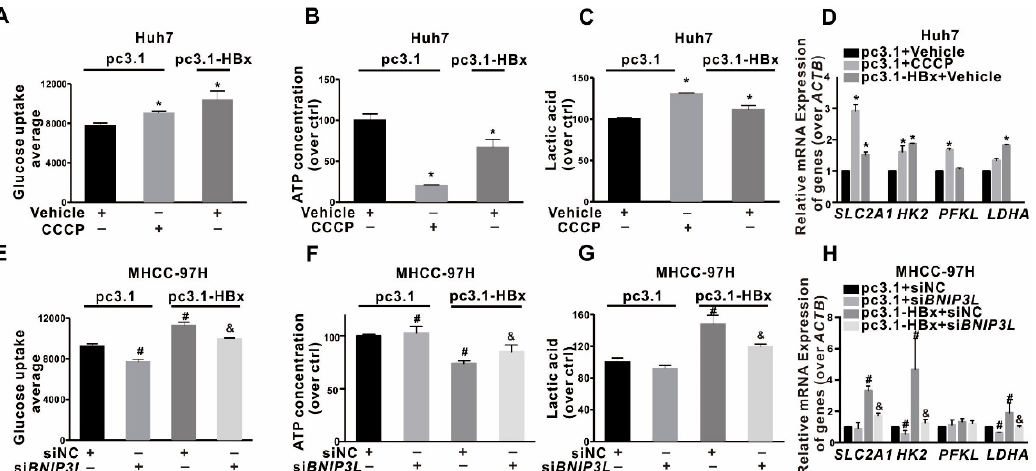
Figure 7. Relationship between the BNIP3L-dependent mitophagy and glycolysis metabolism reprogramming in HBx-expressing HCC cells. ( A – D ) Huh7 cells without or with HBx-expressing were transiently transfected with pcDNA3.1 or pcDNA3.1-HBx (1 μ g/mL) for 8 h, and pretreated with CCCP (20 μ M) for 3 h or not. ( A ) Glucose transport activity was evaluated by FCM. The levels of the intracellular ATP content ( B ), the extracellular lactic acid secretion ( C ), and the mRNA levels of glycolysis-related genes ( D ) were detected. ( E – H ) MHCC-97H cells without or with HBx-expressing were simultaneously transfected with si BNIP3L or siNC (50 nmol/L) for 8 h, and followed by restored culture for another 24 h. ( E ) Glucose transport activity was evaluated by FCM. The levels of the intracellular ATP content ( F ), the extracellular lactic acid secretion ( G ), and the mRNA levels of glycolysis-related genes ( H ) were detected. The target gene transcription was normalized to ACTB. * P < 0.05 as compared with pc3.1+Vehicle group, # P < 0.05 as compared with pc3.1+siNC group, & P < 0.05 as compared with pc3.1-HBx+siNC group. pc3.1: pcDNA3.1 transfection without HBx-expressing.